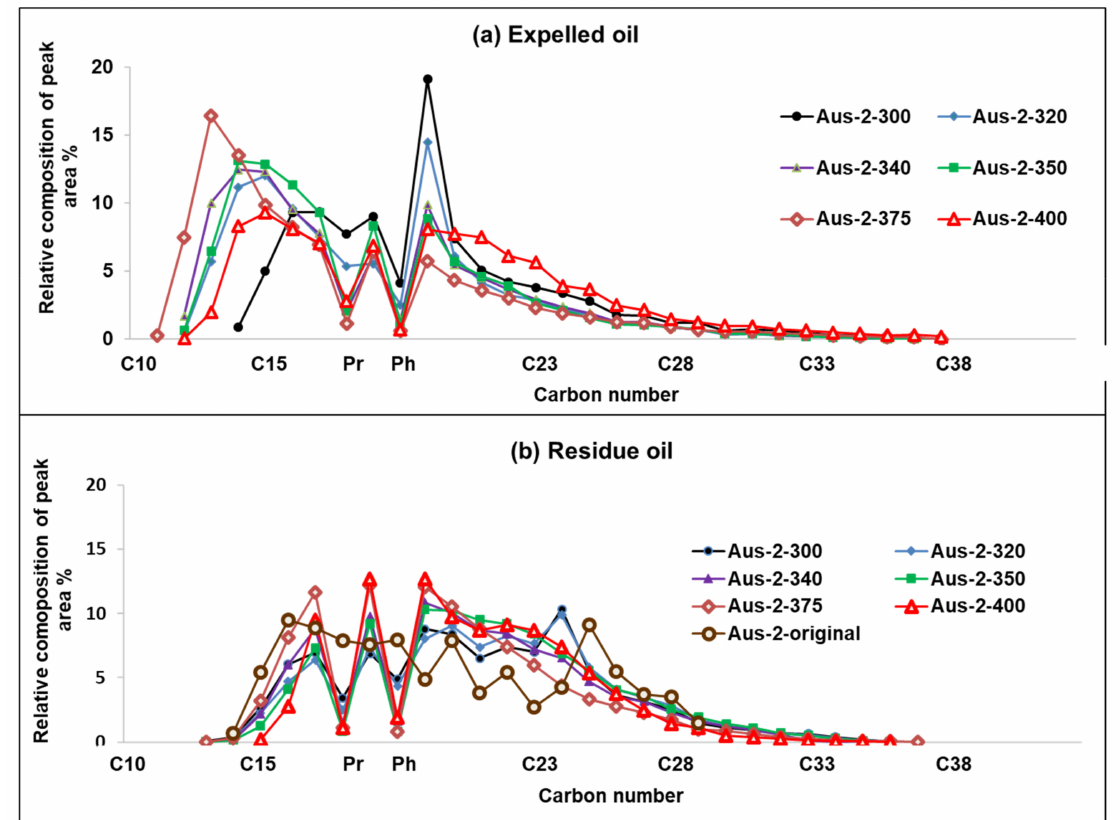
Figure 8. The relative composition of n -alkanes and isoprenoids from gas chromatography of expelled oil ( a ) and residual oil ( b ) of Aus-2 as a function of temperature in the artificial maturation experiments. Pr: pristane; Ph: phytane.